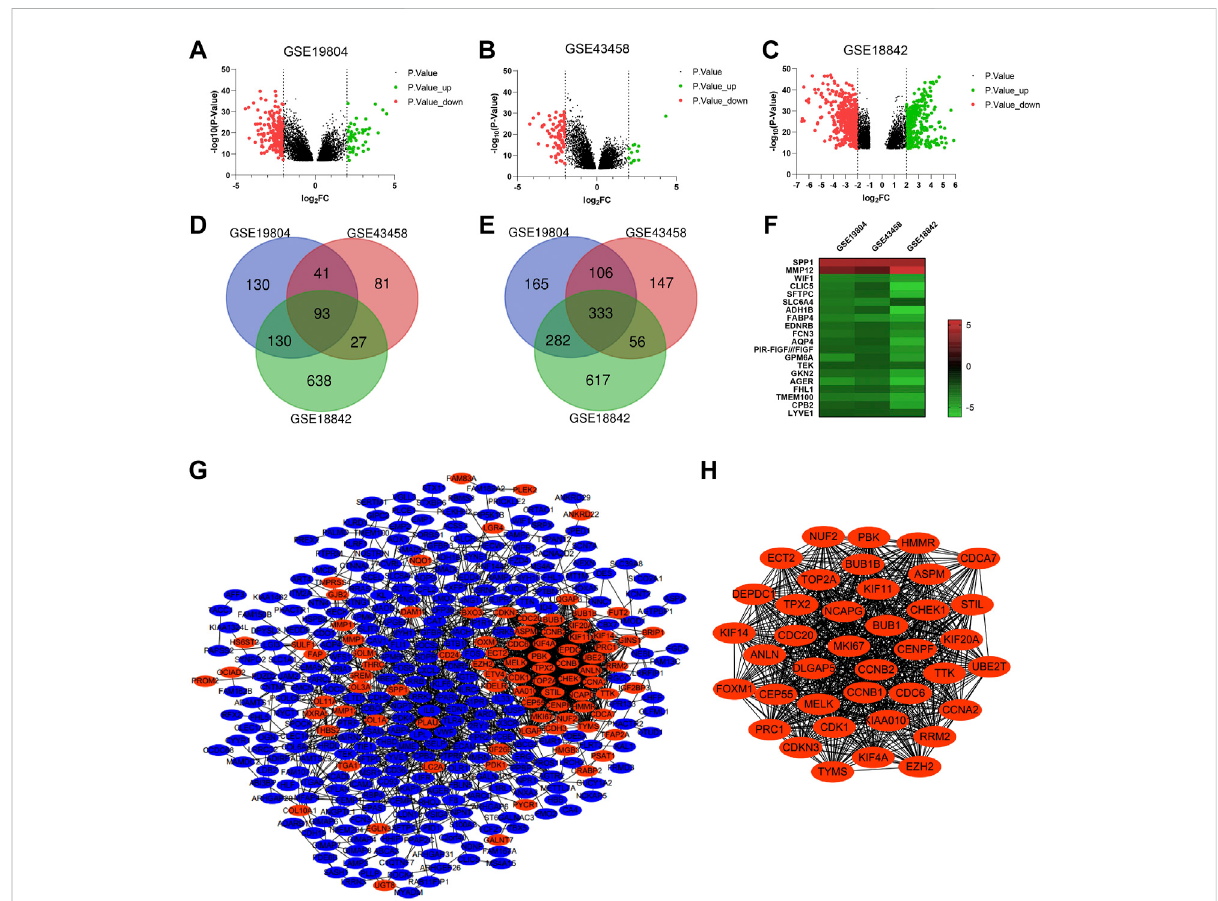
FIGURE 2 Identi fi cation of overlapping DEGs and PPI construction of DEGs. (A-C) Volcano plots showing DEGs in NSCLC tissues compared to normal tissues in GSE19804/GSE43458/GSE18842 (|Log 2 FC| ≥ 2 and p < 0.05). (D and E) Venn diagrams showing the number of overlapping DEGs in the three GEO datasets (D. up-regulated genes E. down-regulated genes). (F) Heatmap of the top representative DEGs (|Log 2 FC| ≥ 2.5 and p < 0.05). (G) PPI network of DEGs constructed by the String and Cytoscape software. (H) The most signi fi cant module of PPI network based on the score of each node. (Red represents up-regulated, blue represents